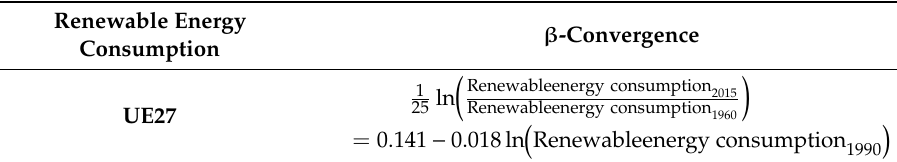
Table 6. Mathematical presentation for Equation